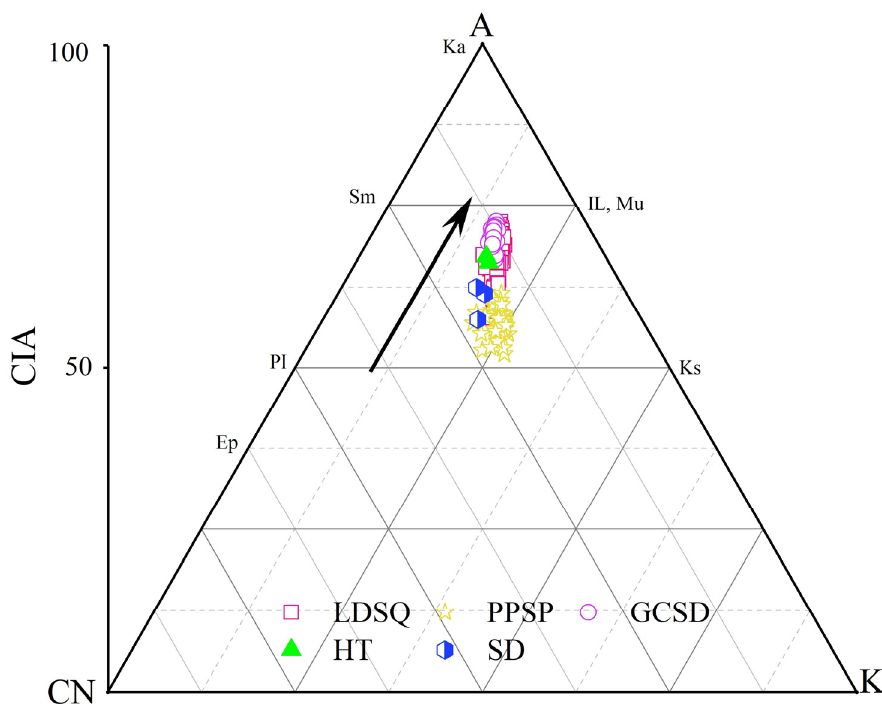
Figure 5. A-CN-K ternary diagram of the modern dune in Dinggye area (the arrows indicate the weathering trend). Ka = Kaolinite; Sm = Smectite; IL = Illite; Mu = Muscovite; Pl = Plagioclase; Ks = K-feldspar, Ep = Epidote; A = Al 2 O 3 ; CN = CaO* + Na 2 O; K = K 2 O.